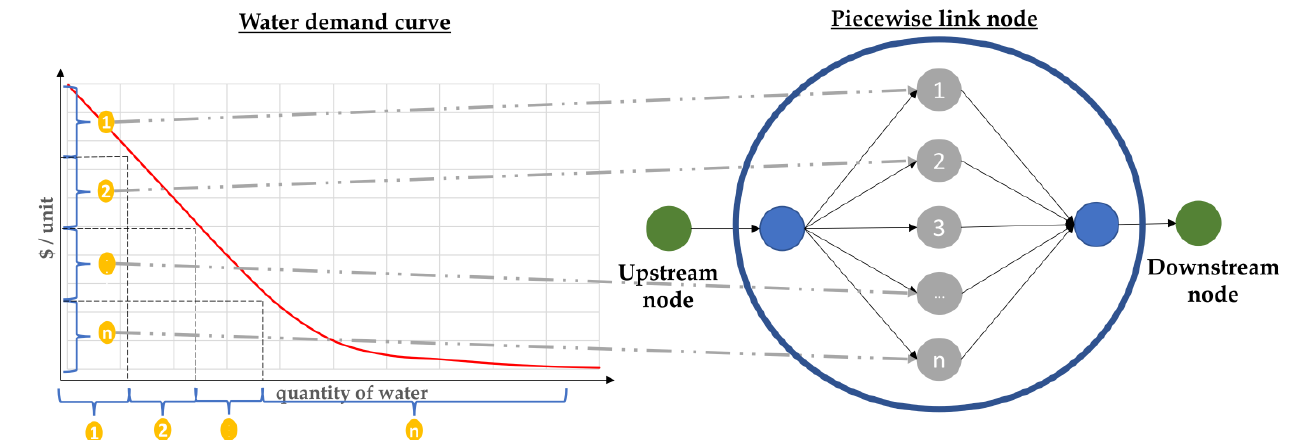
Figure 4. Representation of the hydro-economic node based on piecewise linearization (adapted from [40]).